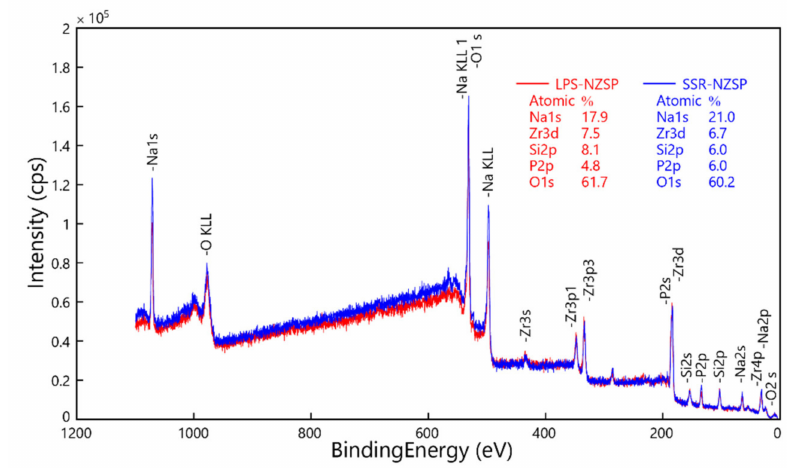
Figure 7. XPS survey spectra of the samples calcined at 1000 ◦ C for 10 h.